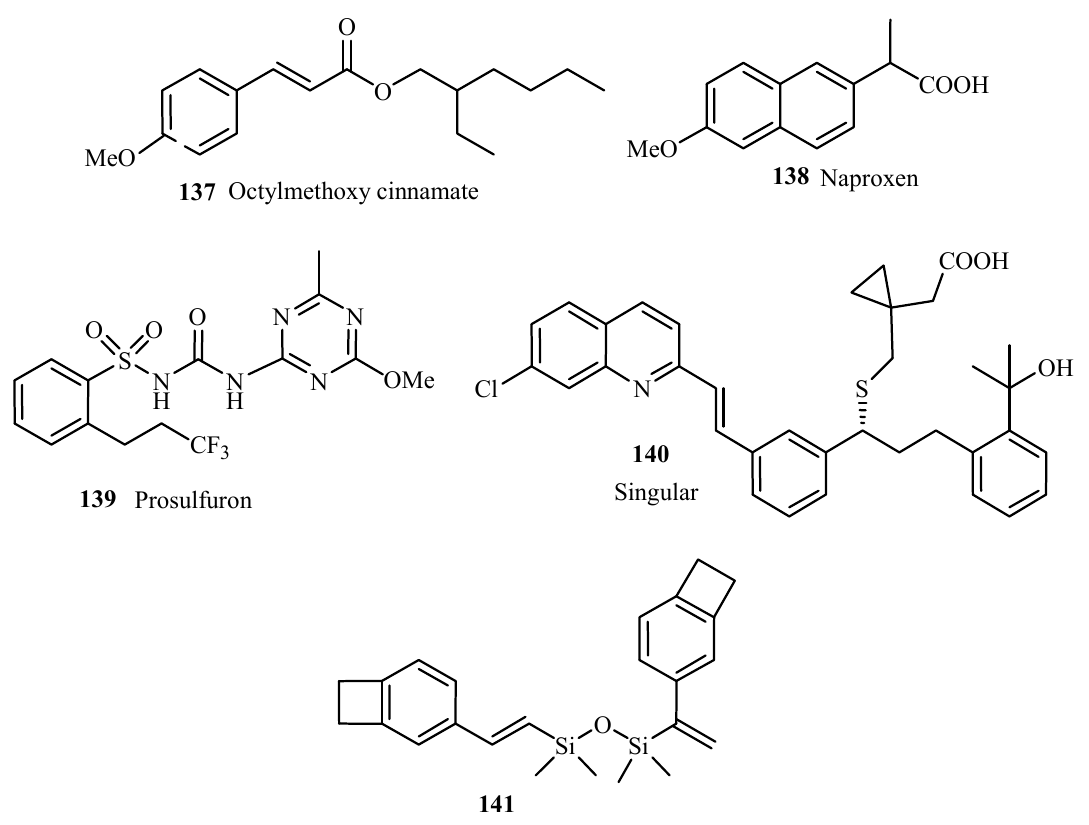
Figure 20. Fine chemical products produced on a scale in excess of 1 ton/year using Heck or Heck type reaction reviewed by deVries [78].